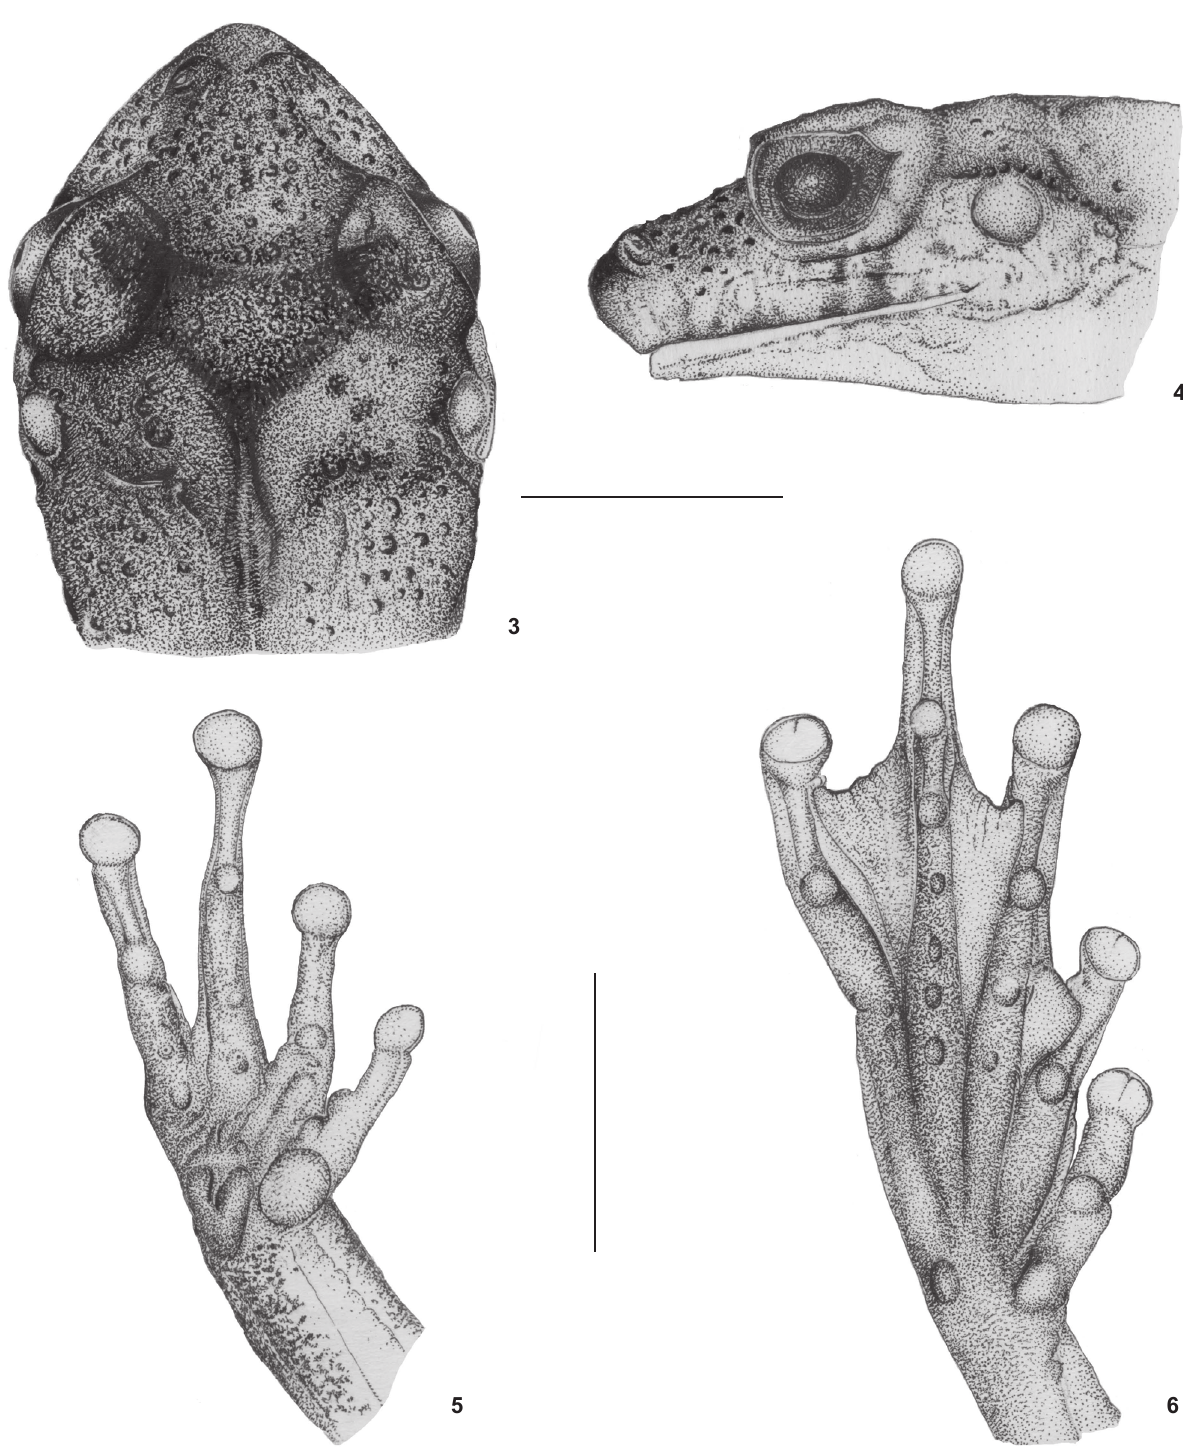
Figures 3-6. Scinax skaios sp. nov. , holotype (MNRJ 54471): dorsal (3) and lateral (4) views of head; ventral views of hand (5) and foot (6). Scale = 5